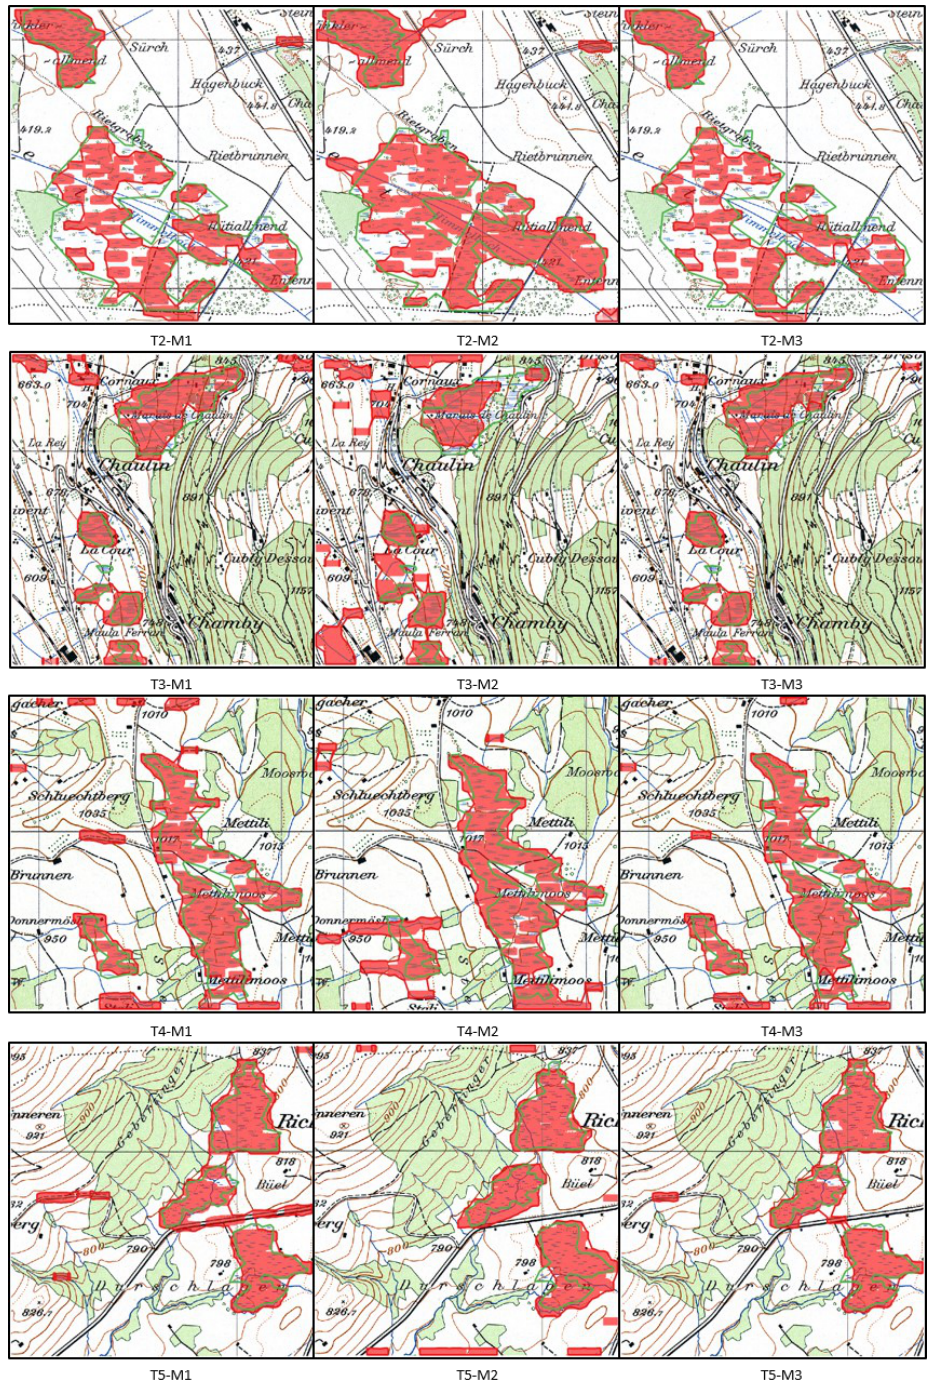
Figure 6. The detection results of Tile 2, Tile 3, Tile 4, and Tile 5. T2-M1 refers to the result of Tile 2 generated by Model1, and the rest of the coded captions can be understood accordingly. Detected wetland signatures are marked in red bounding boxes; Red boundary is the generated wetland boundary and the green boundary marks the ground